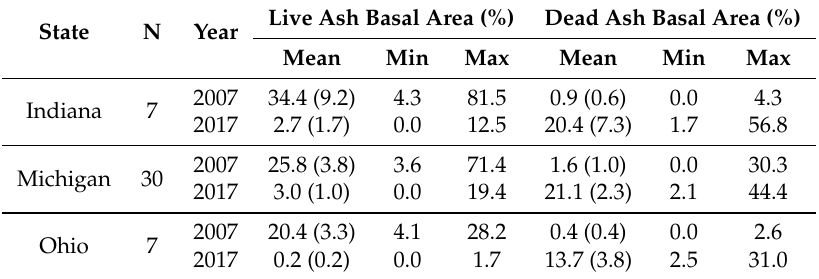
Table 1. Mean percent forest basal area comprised of live and dead ash at sites in Indiana, Michigan, and Ohio, (standard error) with range values. Live Ash Basal Area (%) Dead Ash Basal Area State N Year